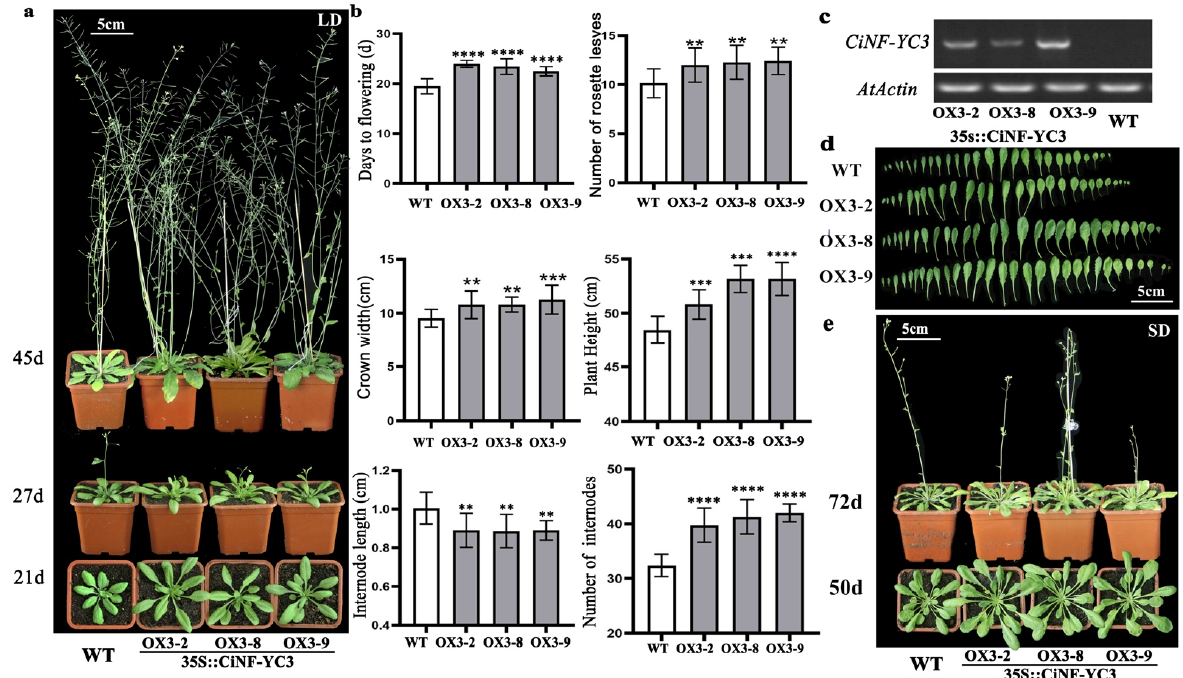
Figure 5. Flowering time and phenotype analysis of CiNF-YC3 overexpressing Arabidopsis . ( a ) Flow- ering time of CiNF-YC3 overexpressing Arabidopsis under LD conditions. ( b ) Phenotype analysis of CiNF-YC3 overexpressing Arabidopsis under LD conditions. Fifteen independent plants were meas- ured, and error bars indicate standard deviation. ** p < 0.01, *** p < 0.001, and **** p < 0.0001 indicate significant differences. ( c ) Identification of CiNF-YC3 overexpressing Arabidopsis by RT-PCR. ( d ) The leaf size of WT plants and CiNF-YC3 overexpressing Arabidopsis . ( e ) Flowering time of CiNF-YC3 overexpressing Arabidopsis under SD conditions.